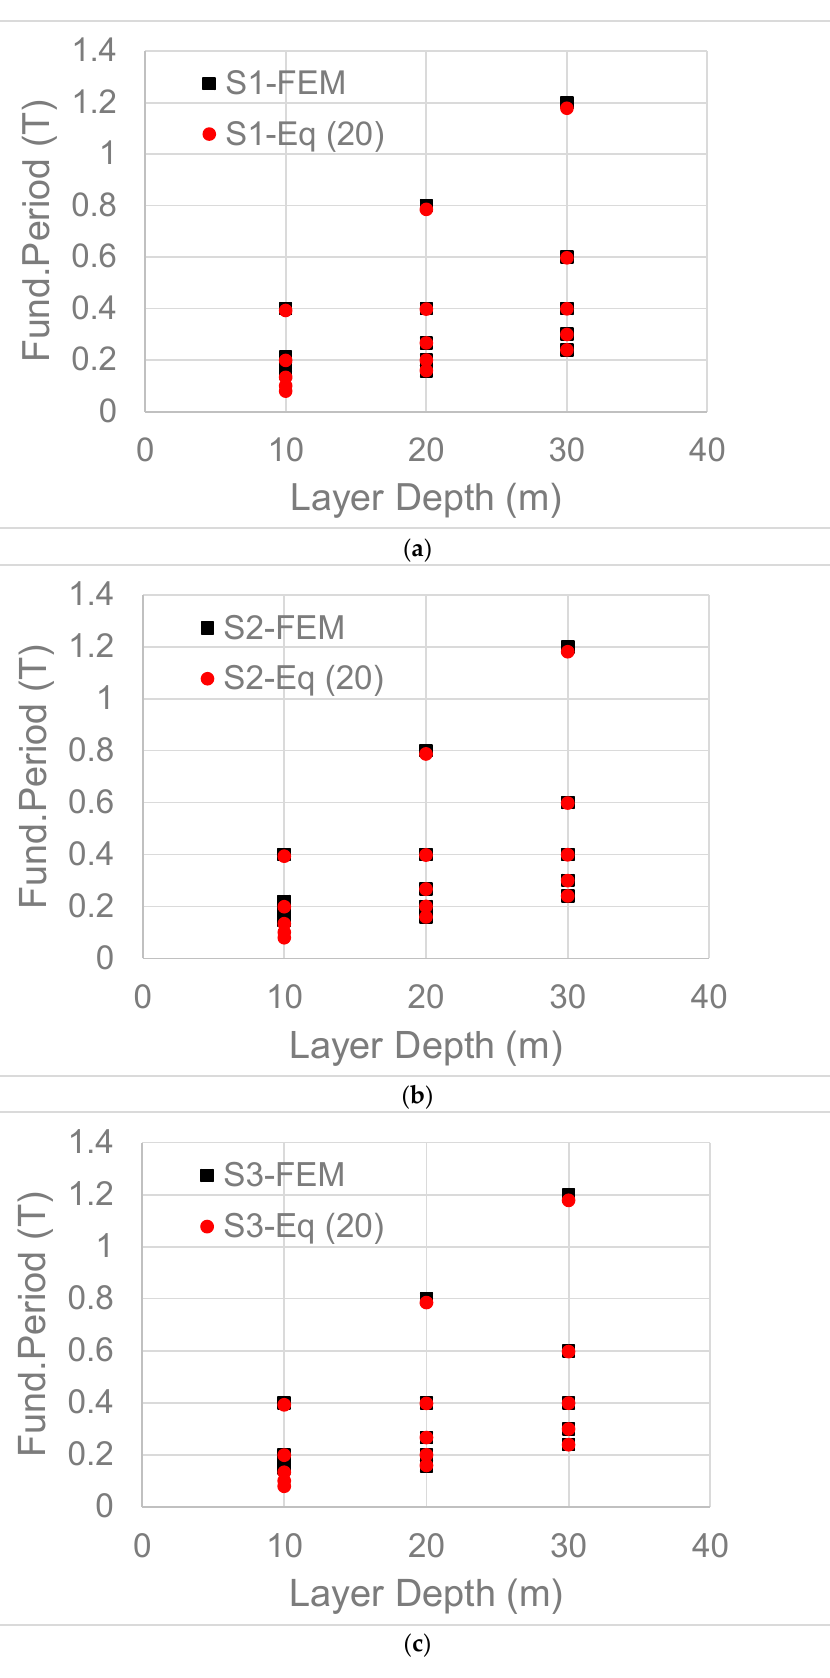
Figure 9. ( a ). Soil S1: comparison (Model1, Model2 and Model3). ( b ). Soil S2: comparison (Model1, Model2 and Model3). ( c ). Soil S3: comparison (Model1, Model2 and Model3).